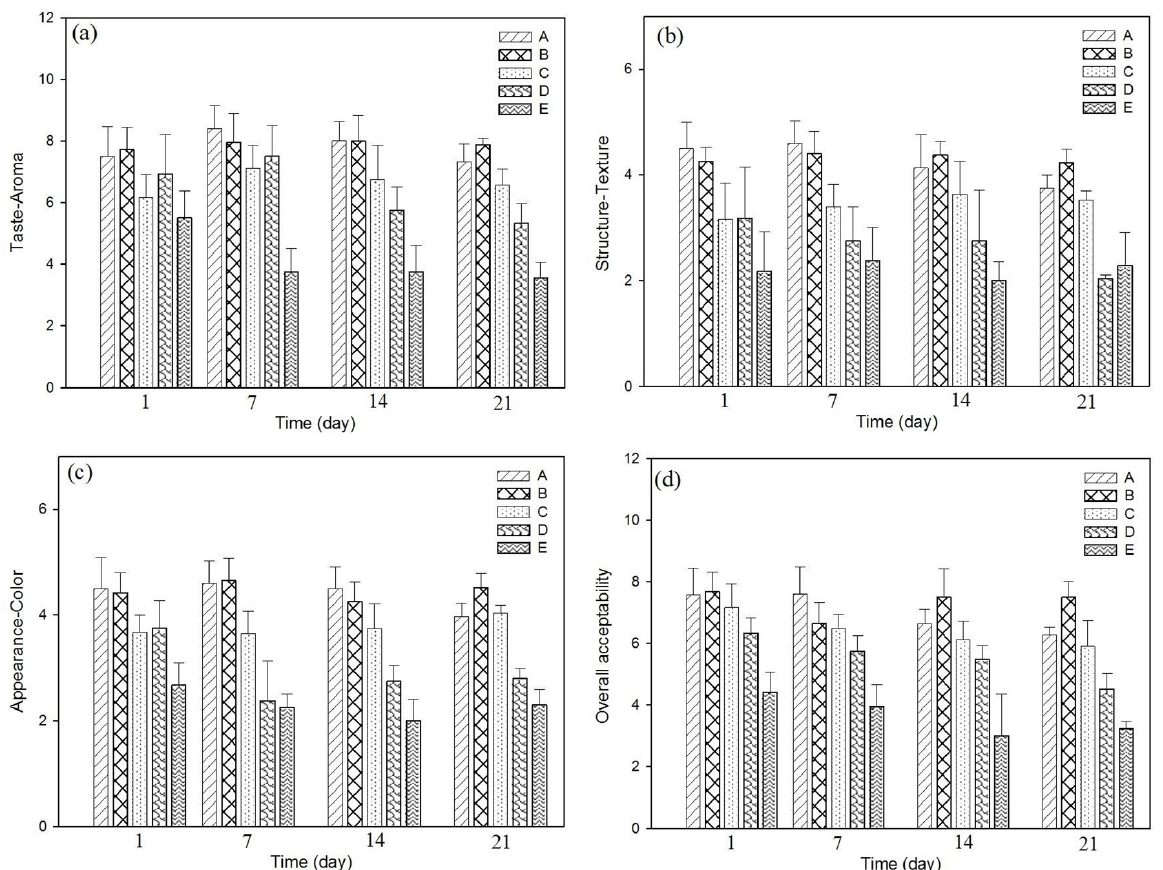
Figure 3. Sensory evaluation of yoghurt-like products produced with cow milk and hazelnut beverage during storage at 4 °C. (a) Taste-aroma, (b) structure-texture, (c) appearance-color, (d) overall